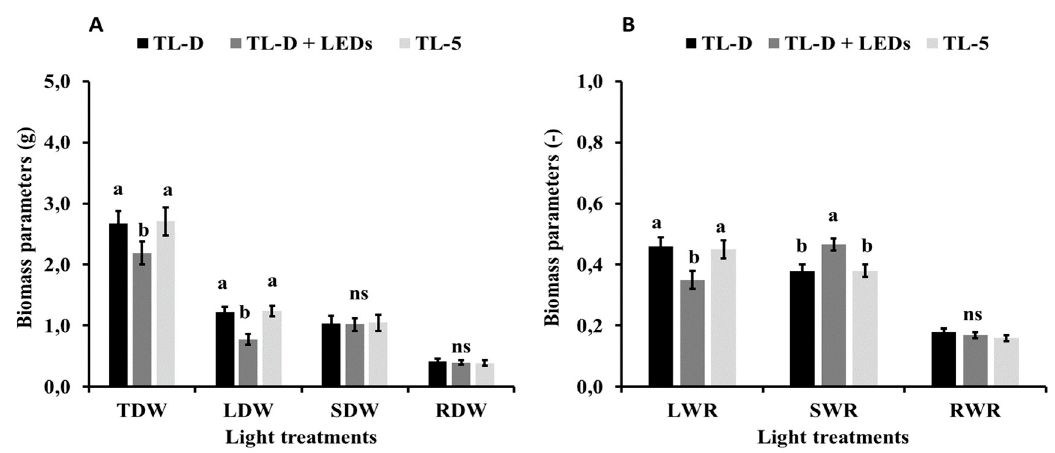
Figure 2. E ff ect of light treatments on leaf (LDW), stem (SDW), root (RDW), and total dry weight (TDW; expressed in g) ( A ), and leaf weight ratio (LWR), stem weight ratio (SWR), and relative root weight ratio (RWR) ( B ) at the end of the experiment (8 weeks). Each parameter was analyzed individually. Values are the means ± standard deviations (error bars) of five plants per treatment. Bars with di ff erent letters are significantly di ff erent at p < 0.05 (analysis of variance (ANOVA) and least significant di ff erence (LSD) tests). ns: not significant.